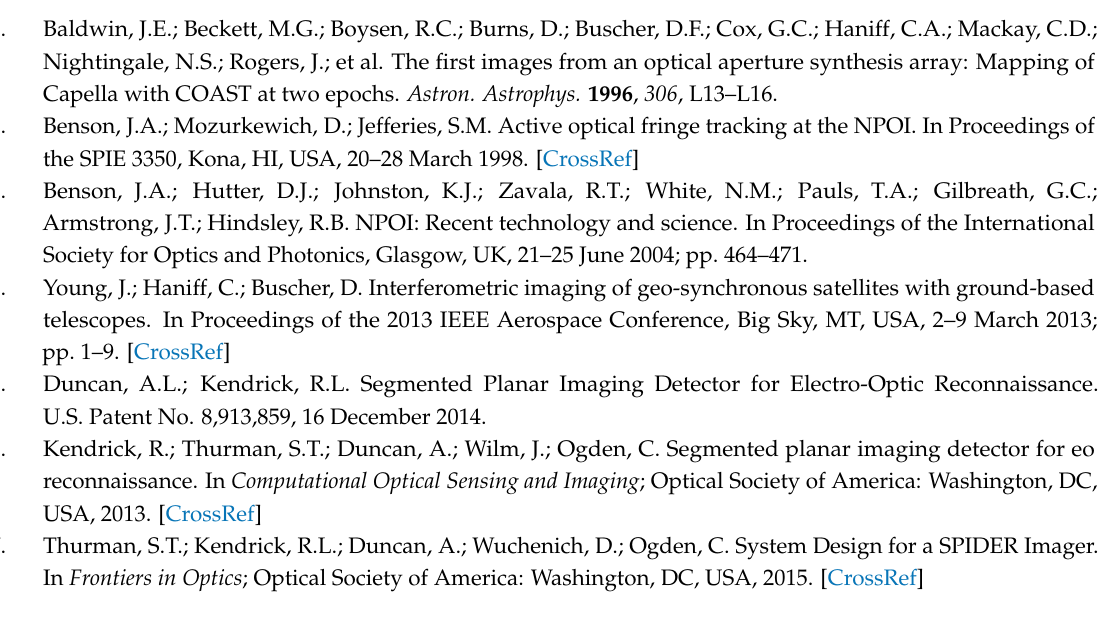
Figure 10. ( a ) Mutual intensity spectrum detected with the complex rectangular sub-aperture arrangement method ( △ u1 = 0.33, △ u2 = 0.66, △ u3 = 1.3, N = 200); ( b ) partial enlargement of the spectrum; ( c ) actual imaging of the system.